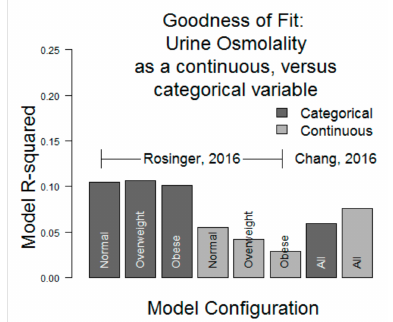
Figure 3. Model goodness (R 2 ) comparison, incorporating hydration as a continuous variable versus categorical variable R 2 < 0.12 in all